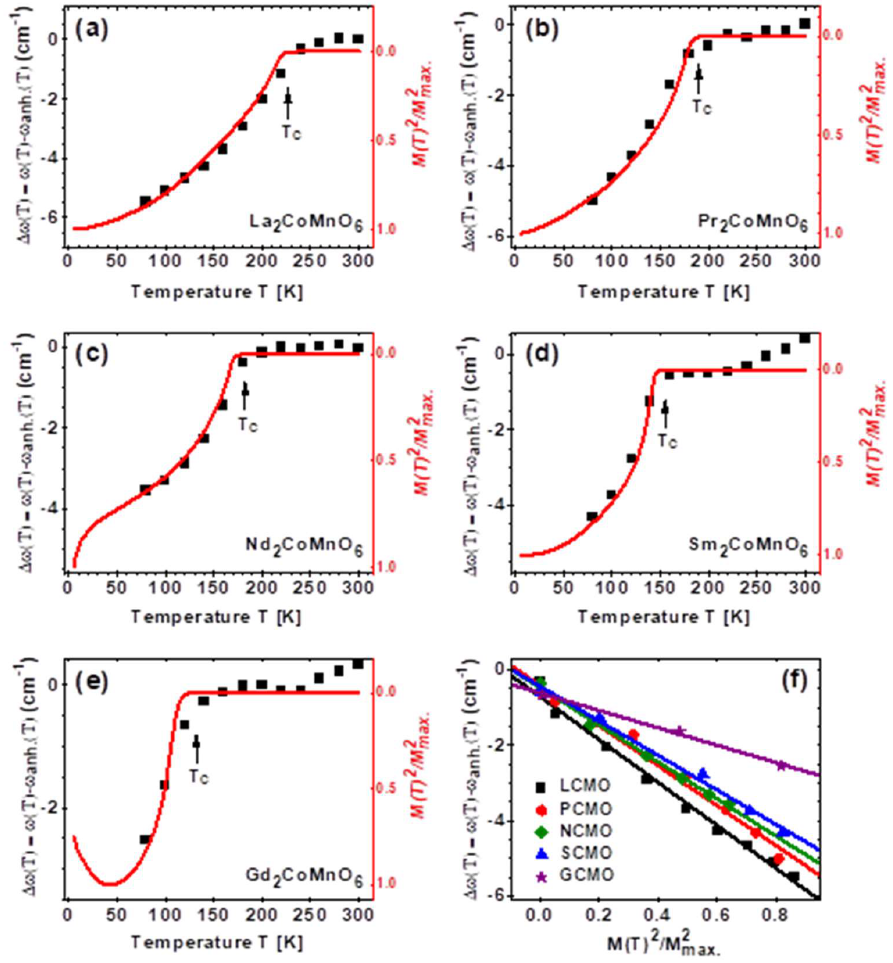
Figure 4. The development of the deviation ∆ ω (T) of the A g breathing mode position from the anhar- monic approximation (phonon renormalization; black data points) and the squared magnetization M 2 (T)/M 2 max with the temperature T for the LCMO ( a ), PCMO ( b ), NCMO ( c ), SCMO ( d ), and GCMO ( e ) double-perovskite thin films on STO(111). Additionally, in ( f ), the corresponding linear approximation between the phonon renormalization ∆ ω (T) and the magnetization M 2 (T)/M 2 max is presented for each of the different A 2 CoMnO 6 /STO(111) thin films of the